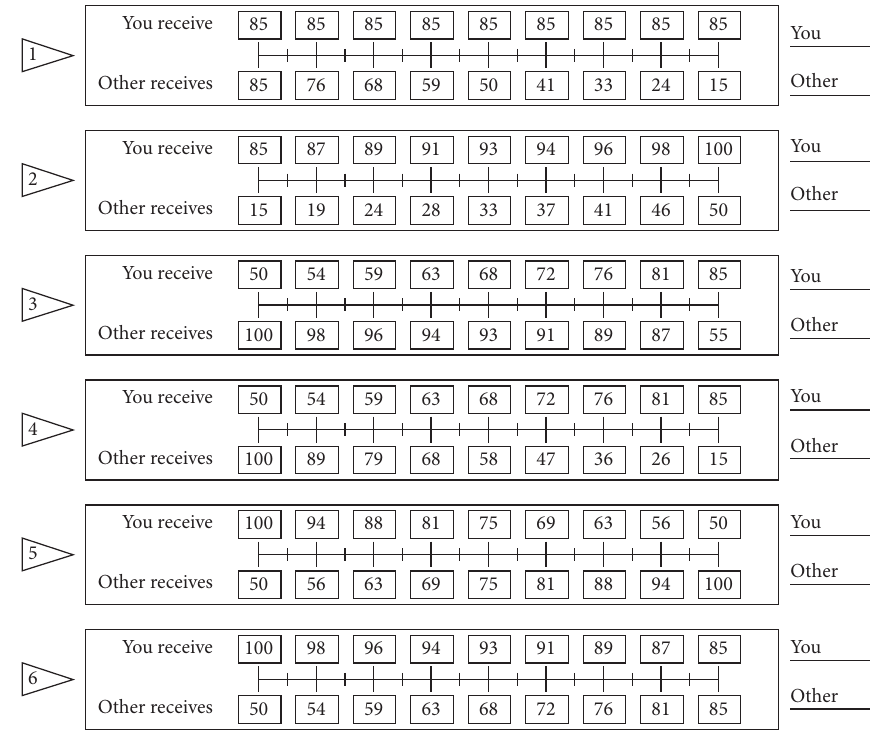
Figure 1: The six primary SVO Slider items (quoted from Murphy [41]).